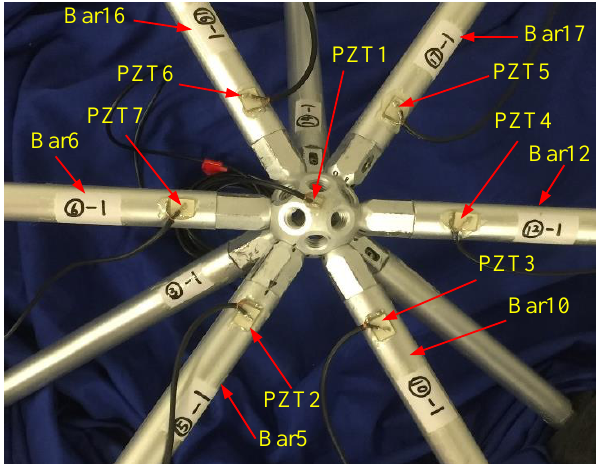
Figure 7. Photo of the surface-bonded PZTs. Table 2. Torque values at different tightness degrees.